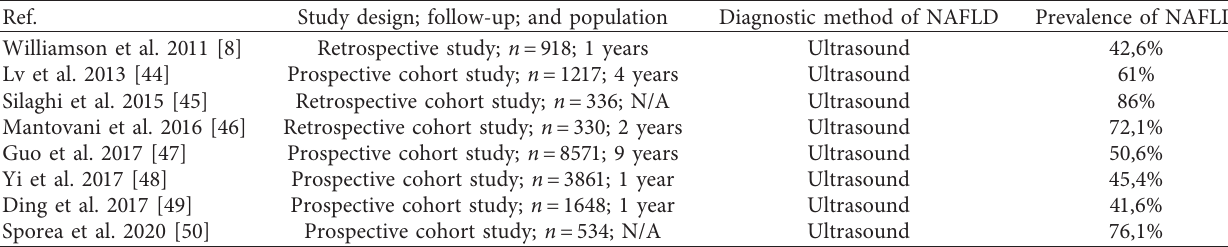
Table 2: Studies which assessed NAFLD prevalence among patients with T2DM.